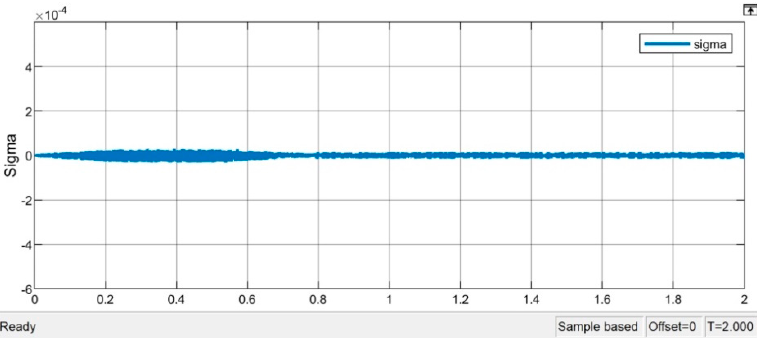
Figure 14. The response of sliding surface σ with load.